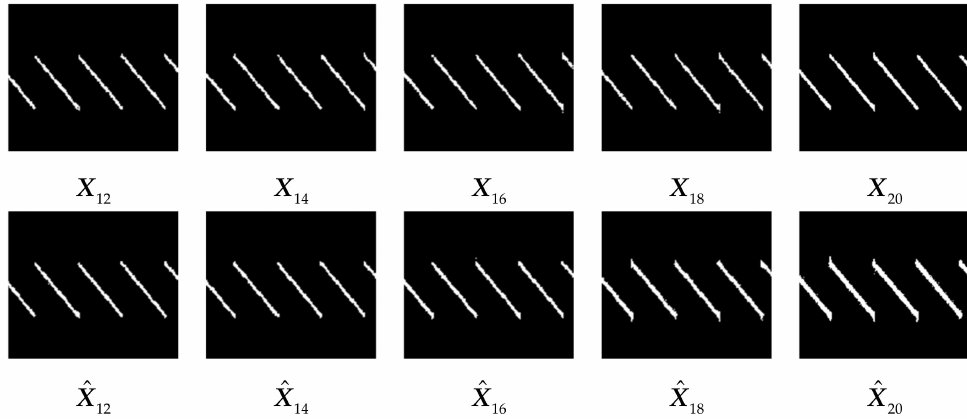
Figure 5. The prediction results for CM-WBI. The first row shows the ground truth and the second shows the predicted results.